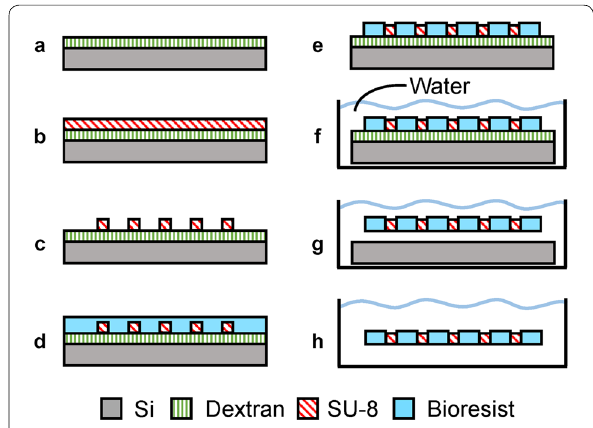
Fig. 6 Soft microrobot fabrication process